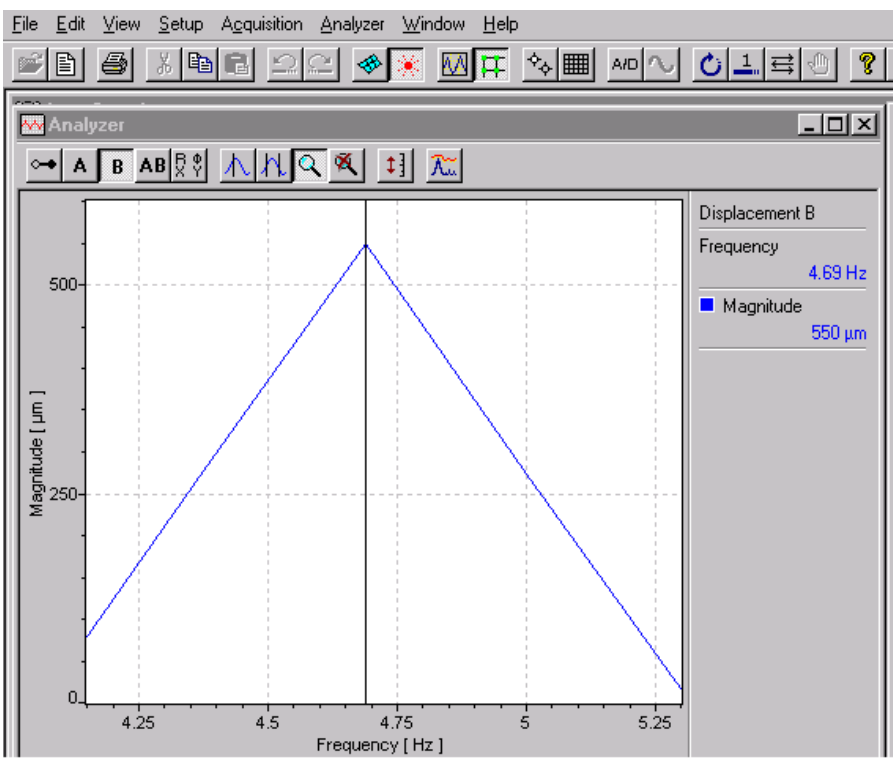
Figure 11. Vibrometer software display used to read the measured values.